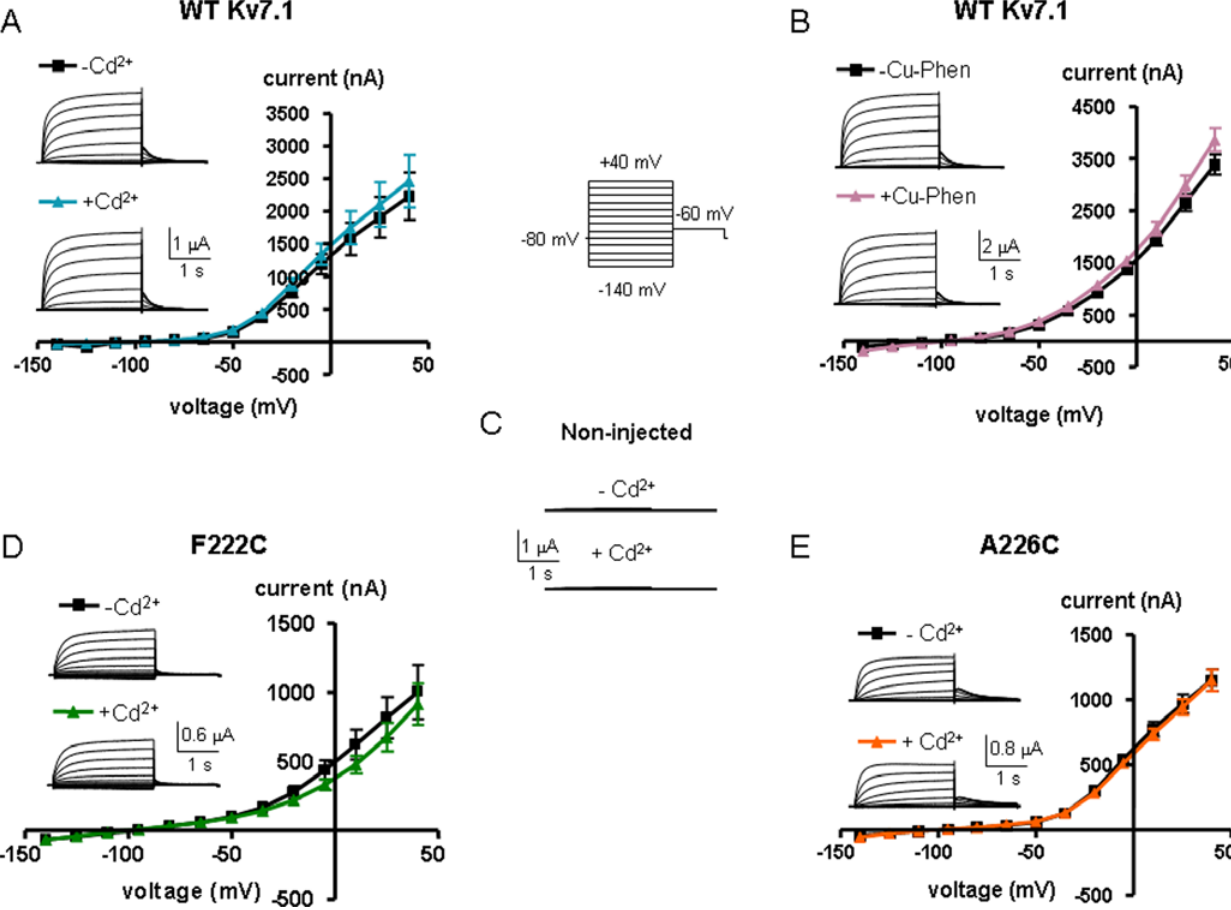
Figure 2. Effects of external Cd 2 + or Cu-Phen on WT Kv7.1 (A and B), non-injected oocytes (C) and mutants F222C (D) and A226C (E). Oocytes were bathed in ND96 in the absence and presence of either 100 m M CdCl 2 or 100 m M Cu-Phen. Currents were evoked by depolarizing steps from 2 140 mV to + 40 mV in 15 mV increments (holding potential, 2 80 mV; tail potentials 2 60 mV), as shown in the scheme protocol between panels A and B. Shown are representative traces and current-voltage relations were determined as indicated.